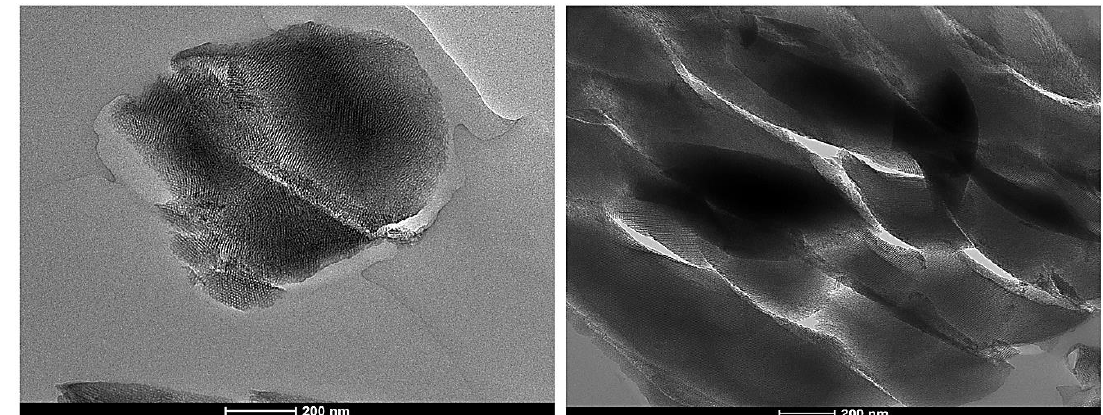
Figure 11. TEM (transmission electron microscopy) photomicrograph of synthesized mesoporous silica particles (SBA-15). Bar, 200 nm.